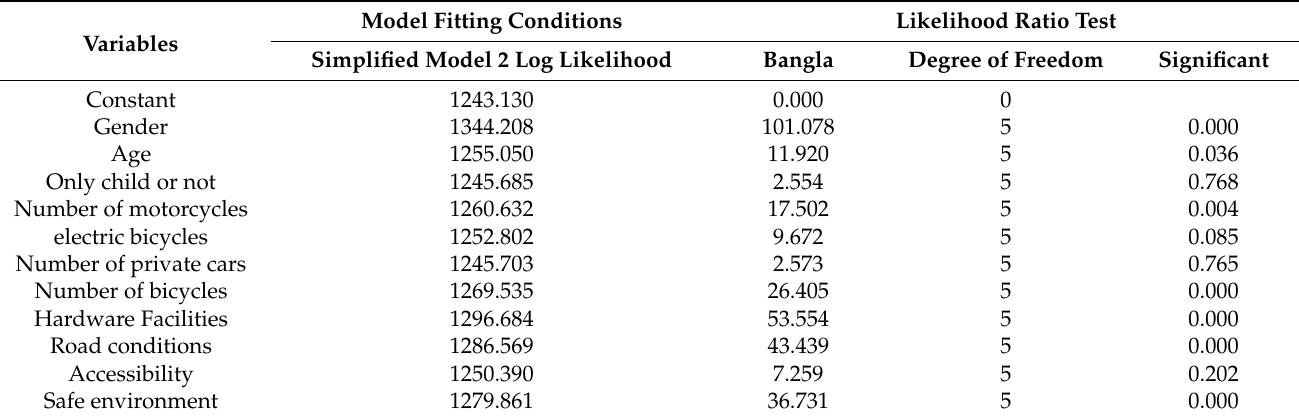
Table 8. Likelihood ratio test for independent